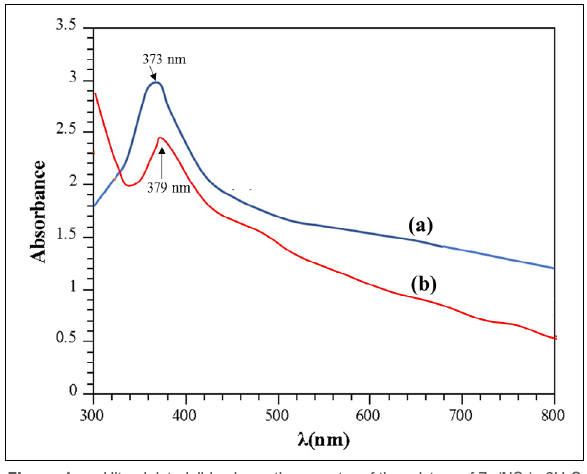
Figure 1: Ultraviolet-visible absorption spectra of the mixture of Zn(NO with extracts of (a) Chromolaena odorata and (b) Manihot esculenta stirred for 12 h, indicating the formation of ZnONPs observed at 373 nm and 379 nm, respectively.